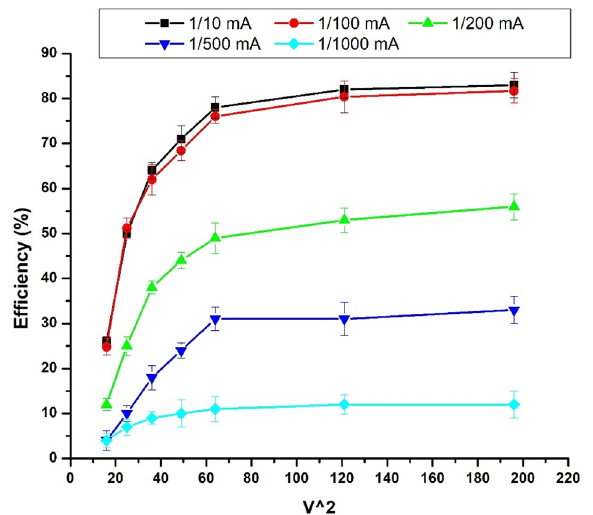
Fig. 8 Fog harvesting efficiency for W0.5-2 collector at different output